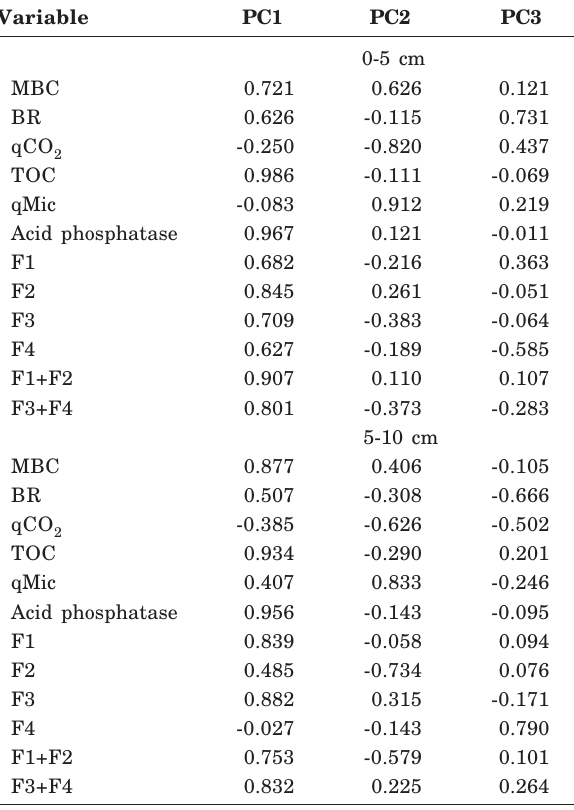
Table 5. Loads of the different variables associated with the principal component (PC) of soils under irrigation regimes and split P